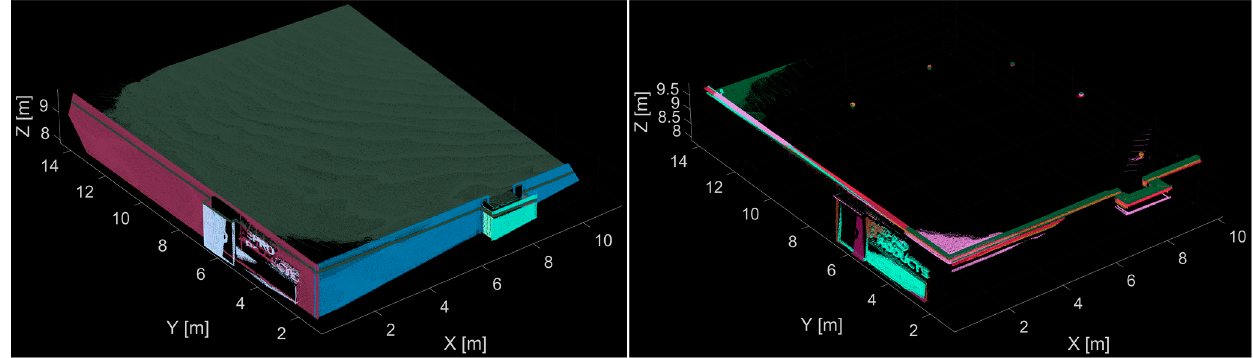
Figure 14. The plane segmentation result using the standard RANSAC algorithm with the correctly segmented planes ( left ), and the incorrectly segmented planes ( right ).